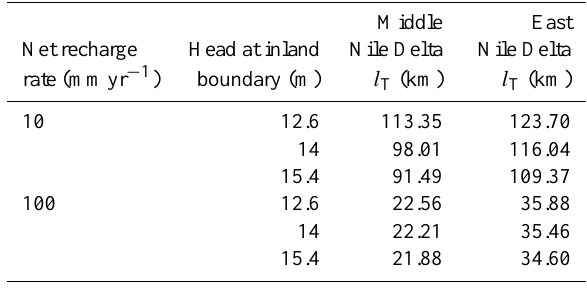
Table 2. Interface toe location, l T , for different conditions of net recharge rate and groundwater head at the inland boundary for the Nile Delta aquifer sections.